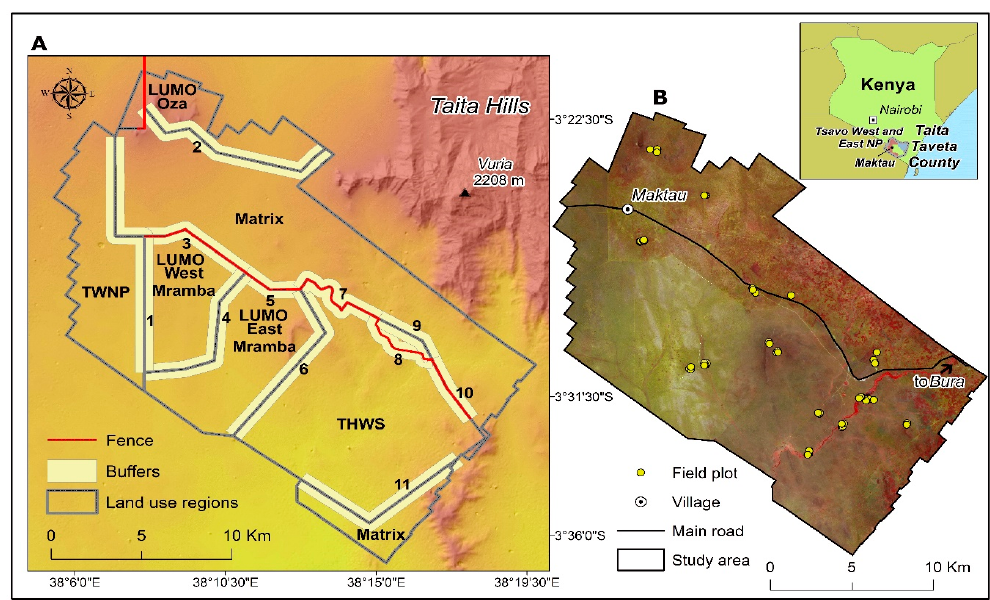
Figure 1. ( A ) Location and topography of the study area with land-use regions, fences, and buffers. Land-use regions: Taita Hills Wildlife Sanctuary (THWS), LUMO Community Wildlife Sanctuary (West Mramba and East Mramba), Tsavo West National Park (TWNP), and other land use (matrix). Numbers refer to buffers. ( B ) False color composite of Sentinel-2 satellite image showing positions of the field plots for woody aboveground biomass (AGB) estimation.